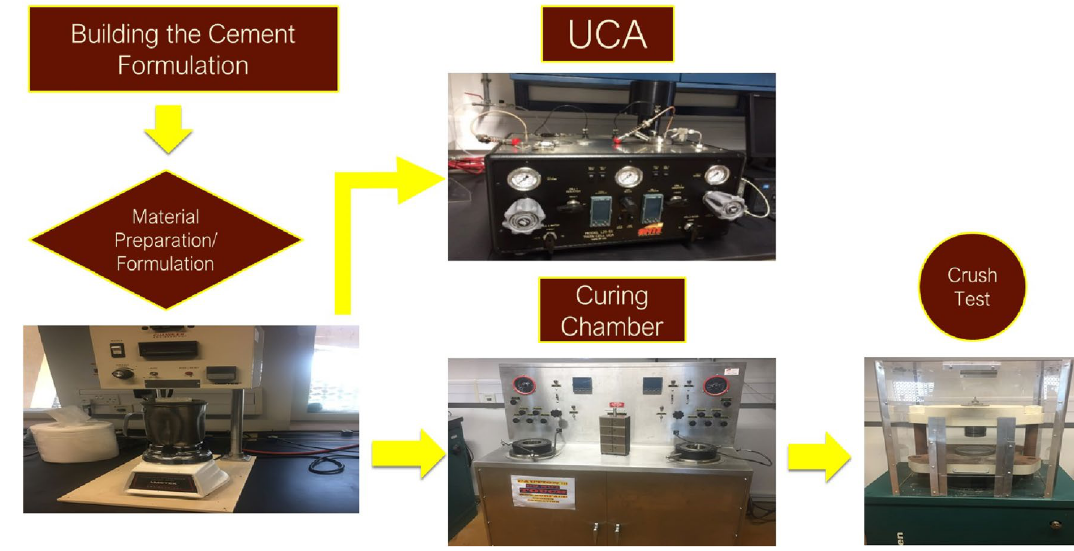
Fig. 12 Flowchart of